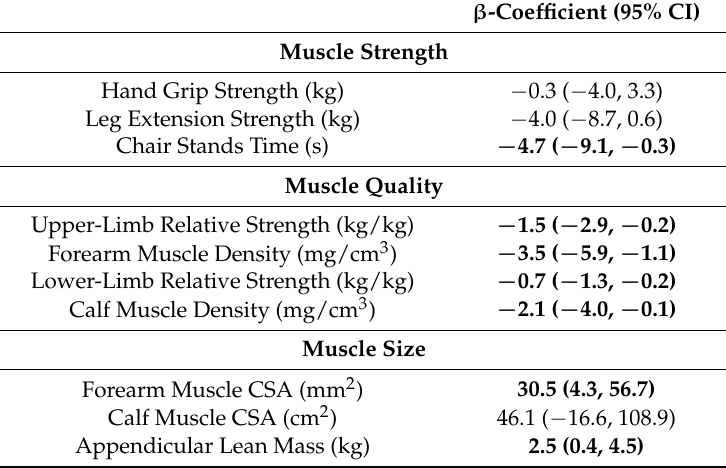
Table 5. Multivariable regression exploring associations between metabolic syndrome and components of